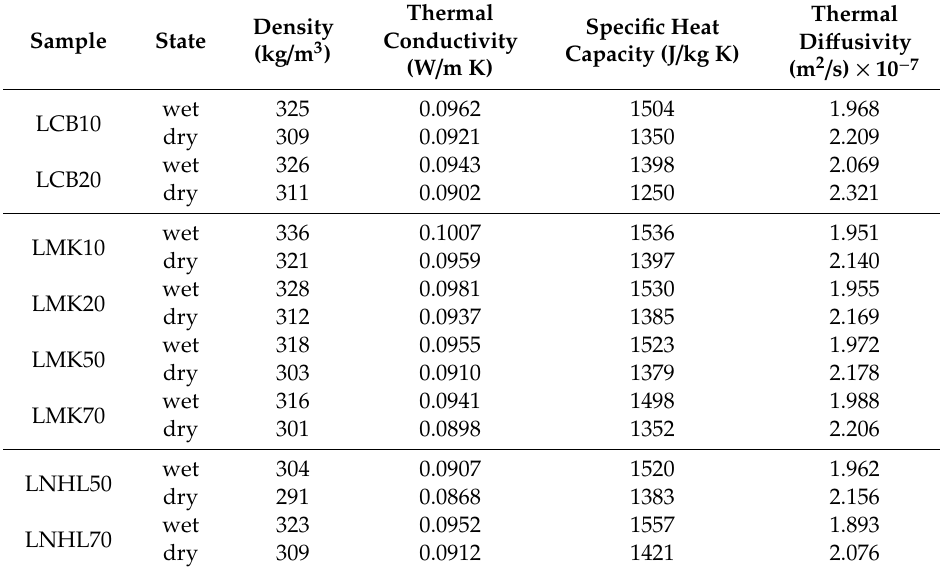
Table 4. Thermal properties of the hempcrete